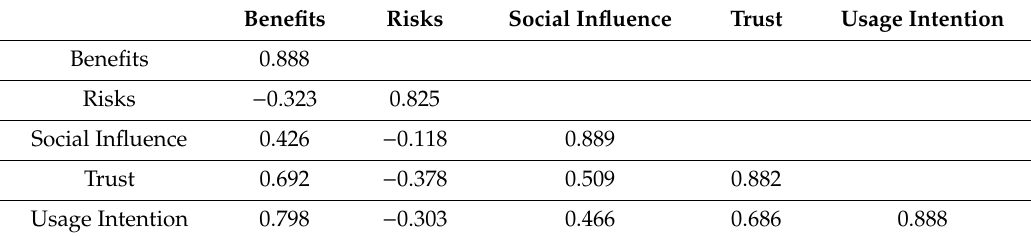
Table 3. Discriminant validity average variance extracted (AVE) values.